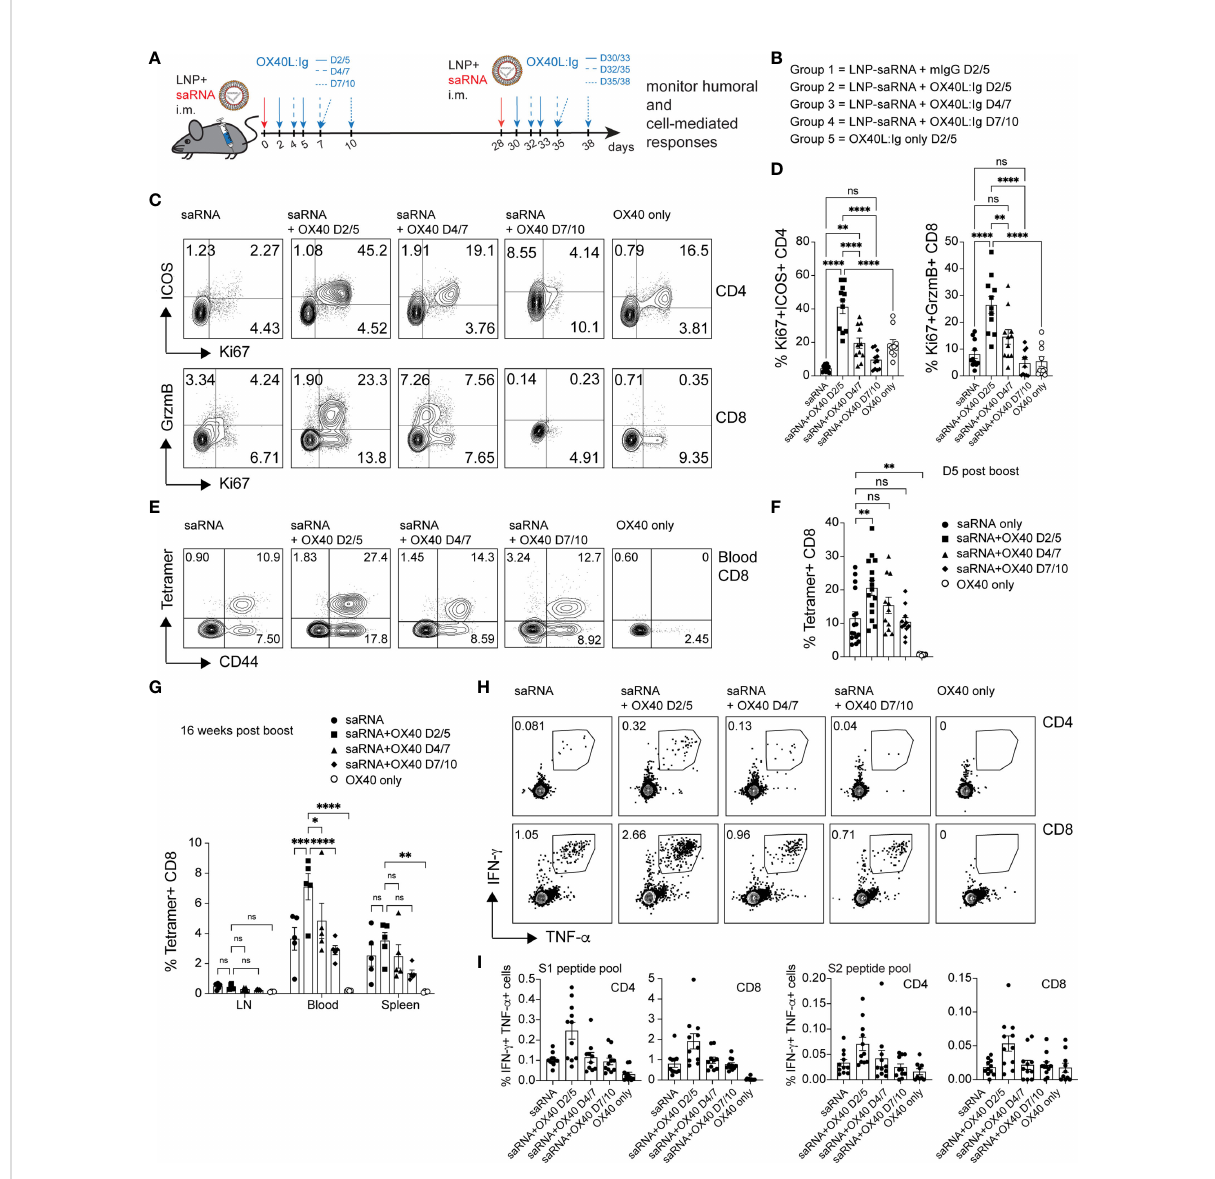
FIGURE 5 OX40 agonists enhance T cell responses in mice immunized with a self-amplifying RNA vaccine. Groups of mice were immunized i.m. with self- amplifying RNA (saRNA), encoding the spike-protein, encapsulated in lipid nanoparticles (LNPs). Mice received the vaccine alone or with OX40 stimulation on days 2/5, days 4/7 or days 7/10 post-vaccination. (A) Schematic representation of the timing of the administration of the saRNA vaccine w/wo OX40L:Ig. (B) Description of the experimental group layout. D=day (C) Flow cytometric assessment of the upregulation of ICOS/ Ki67 on peripheral blood CD4 T cells and GrzmB/Ki67 on CD8 T cells fi ve days after the 1 st OX40L:Ig dose. The dot plots shown are from representative mice in each group. Numbers in each quadrant indicate percent positive cells. (D) Summary of the percentage activated Ki67 +ICOS+ Tconv CD4 cells and Ki67+GrzmB+ CD8 T cells in blood. Bars indicate mean ± SEM. (E) Flow cytometric assessment of the frequency of tetramer+ CD44+ CD8 T cells 5 days post-boost (in each group). Each plot is from a representative animal per group. Numbers in the upper two quadrants represent the tetramer+ cells. (F) Summary of the data in (E) . (G) Summary of tetramer+ T cells in blood, LN and spleen, 16 weeks post-immunization (day118). (H) Mice were euthanized at day124. Frequency of IFN- g + and TNF- a + CD4 and CD8 T cells among splenocytes after in vitro stimulation with the S1 peptide pool. One representative animal per group is shown. The outlined box indicates the IFN- g +TNF- a + double-positive cells. (I) Summary of the frequency of IFN- g +TNF- a + CD4 and CD8 T cells stimulated with either S1 or S2 peptide pools in vitro . Bar graphs show the mean frequencies ± SEM per group in D, F, G and (I) One-way ANOVA with Tukey ’ s multiple- comparisons test. *P<0.05, **P<0.01, ***P<0.001, ****P<0.0001, ns, not signi fi cant. N=10-11 animals per group in D, F, G , and (I) 1 of 2 experiments is